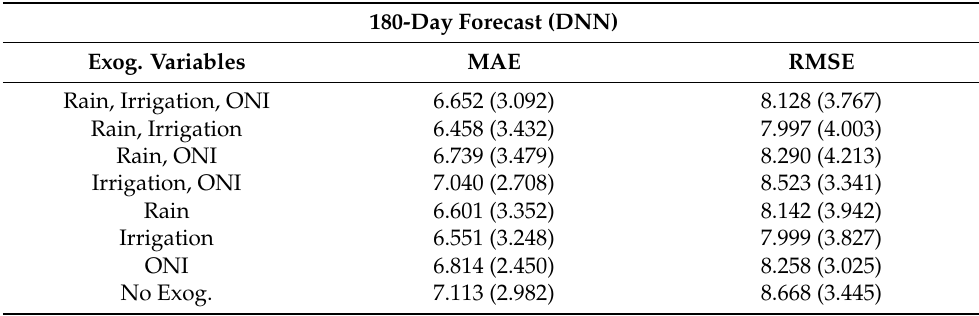
Table 9. Average estimates for MAE and RMSE, and their standard deviations calculated using TSCV for a 180-day forecast across different combinations of exogenous